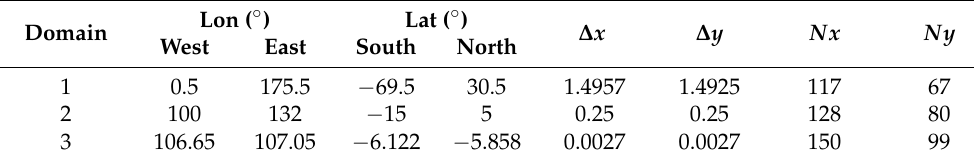
Figure 7. As in Figure 6, for domains II ( left plot ) and III ( right plot ) for Jakarta Bay area. Table 1. Numerical configuration for SWAN model for the Jakarta Bay